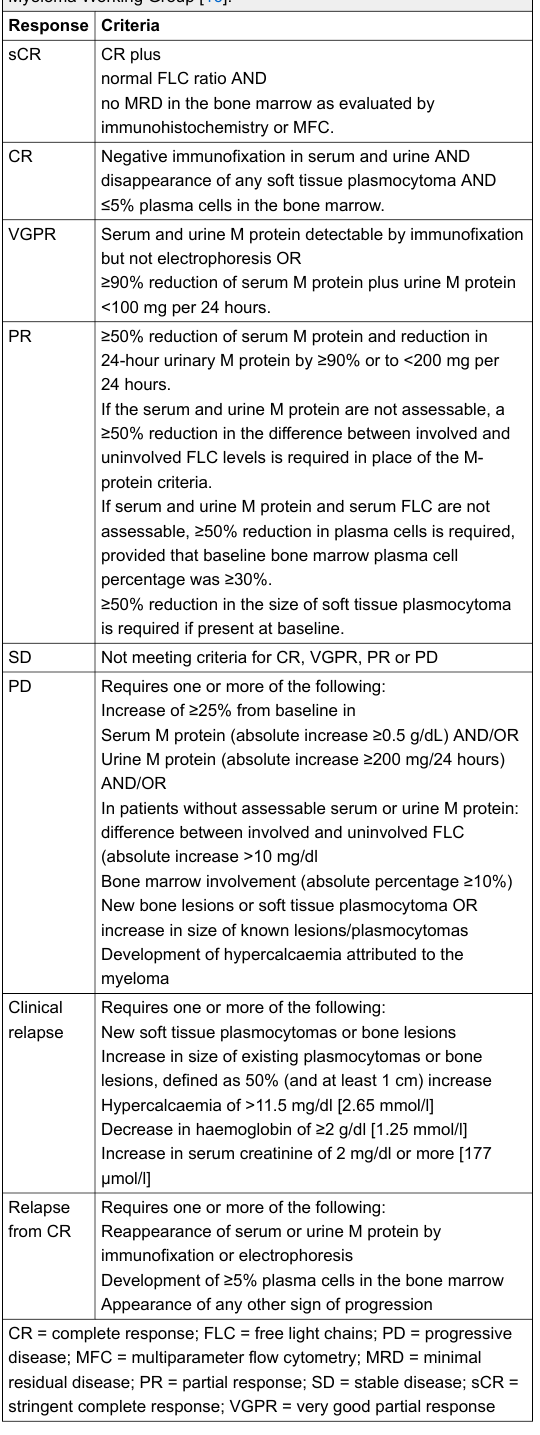
Table 1: International response criteria according to the International Myeloma Working Group